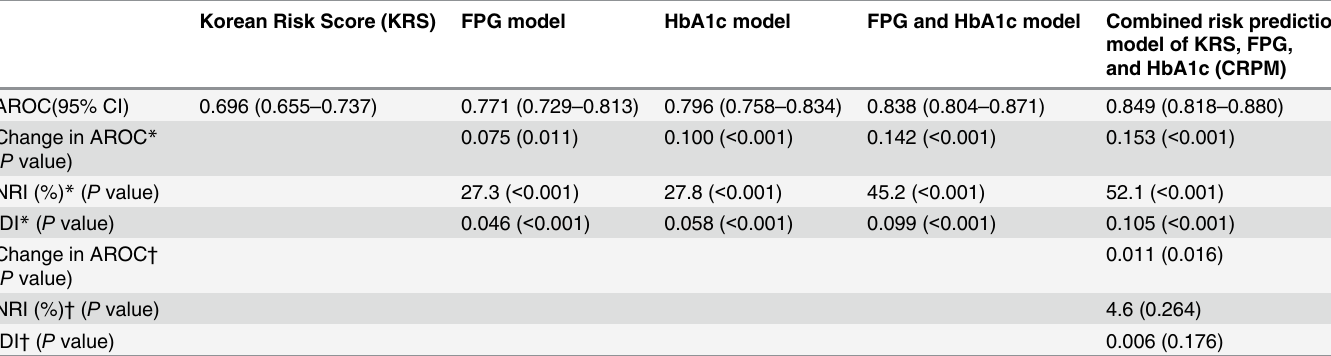
Table 4. Comparison between the Korean Risk Score and risk prediction models of laboratory